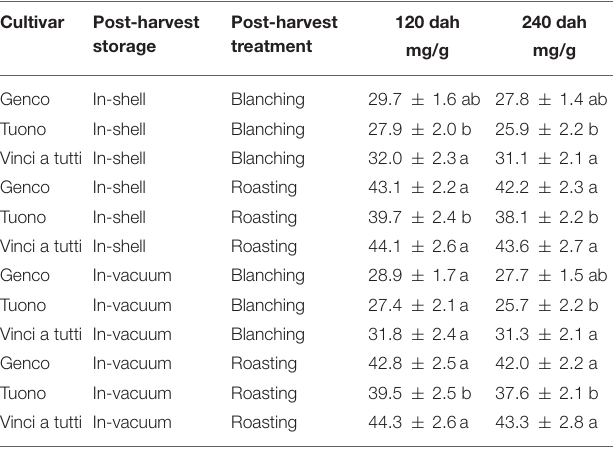
TABLE 4 | Proanthocyanins in the seed skin of three Italian almond cultivars at harvest and during in-shell and vacuum storage. Cultivar Post-harvest storage